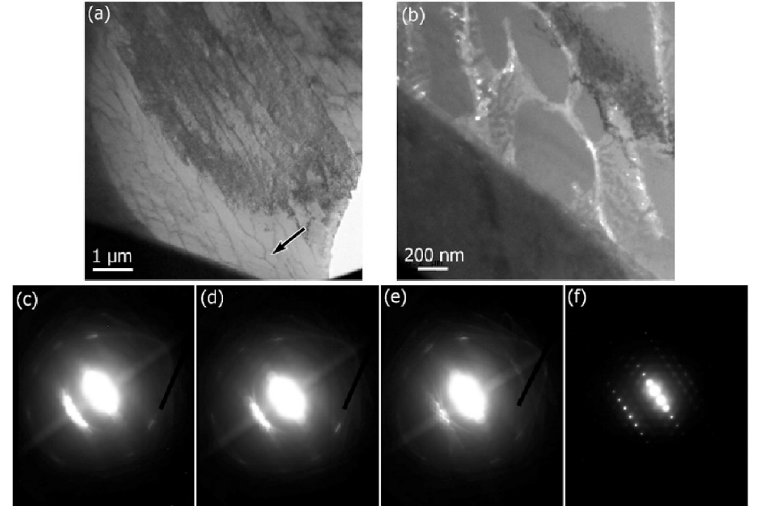
Figure 41. TEM images of AlSi10Mg SLM samples along YZ plane taken using Al-reflection: ( a ) bright-field image and ( b ) dark-field image. The arrow in ( a ) indicates the region from which the dark field image ( b ) was obtained. The corresponding micro-diffraction patterns are shown in ( c – f ). The images in ( c , d ) correspond to the area of the cells on either side of the cell boundary and ( e ) is directly on the cell boundary. ( f ) Shows a diffraction pattern covering the two cells with the cell boundary [172]. Adapted with permission from Elsevier Science Ltd. under the license number 4803740596529